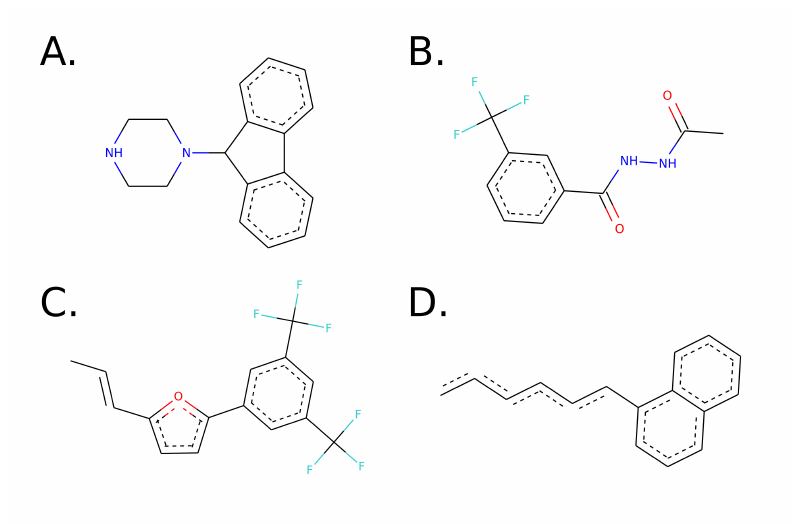
Figure 2. Maximum common substructures of the compounds detected during the virtual screening, split into cluster 1 with 15 molecules ( A ), cluster 2 with 8 ( B ), cluster 3 with 5 ( C ) and cluster 4 with 4 ( D